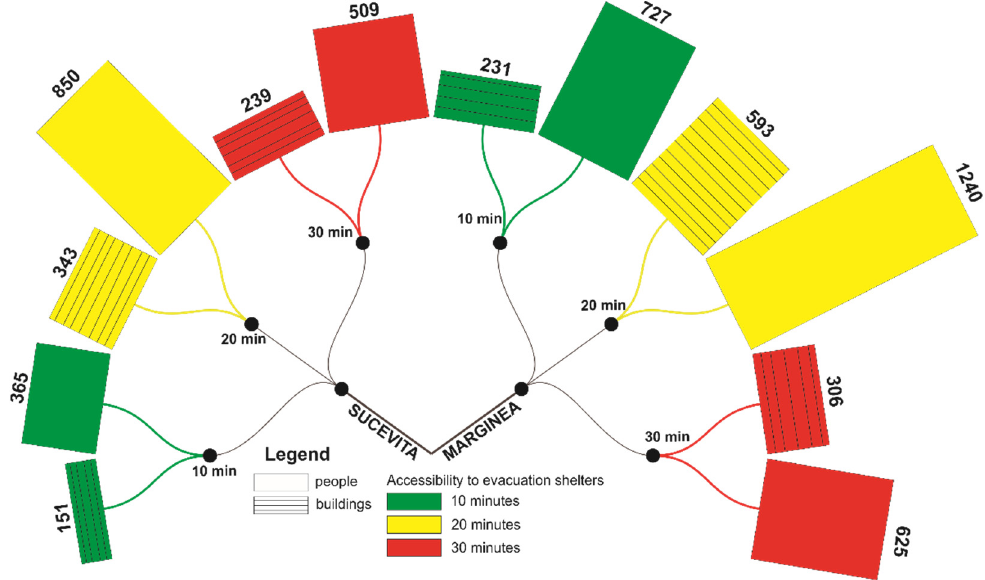
Figure 7. Number of people and dwellings evacuated in 10, 20, and 30 min from the area under review.